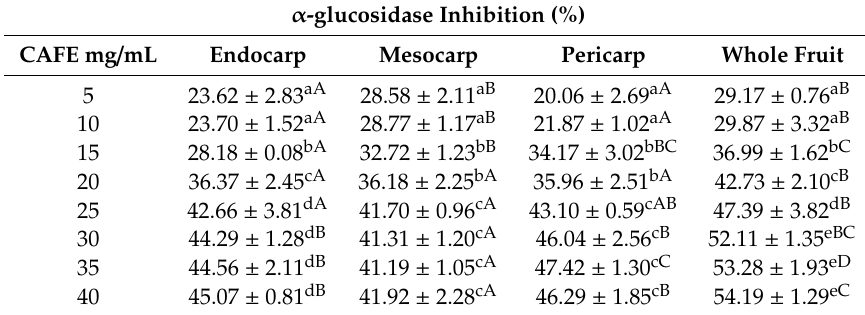
Table 3. E ff ect of the extracts from di ff erent parts of cactus acid fruit (endocarp, mesocarp, pericarp, and whole fruit) in the inhibition α -glucosidase enzyme.